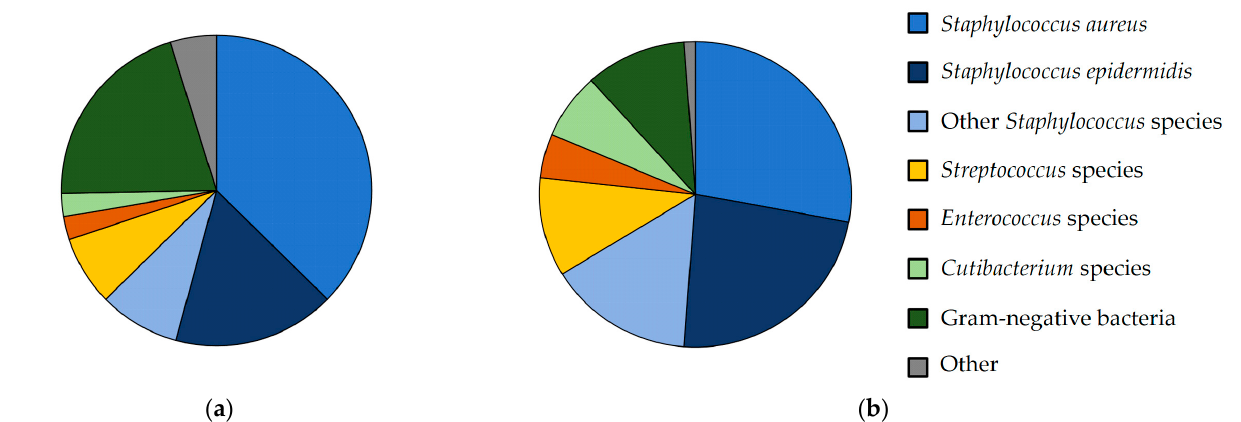
Figure 1. Isolated microorganisms shown in percentage from: ( a ) FRI and ( b ) PJI patients.